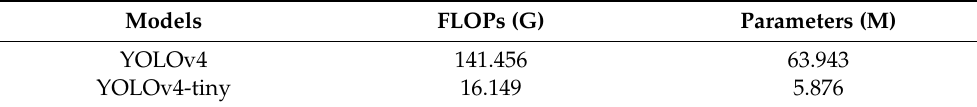
Table 1. Comparison of computational complexity and model size between YOLOv4 and YOLOv4-tiny.